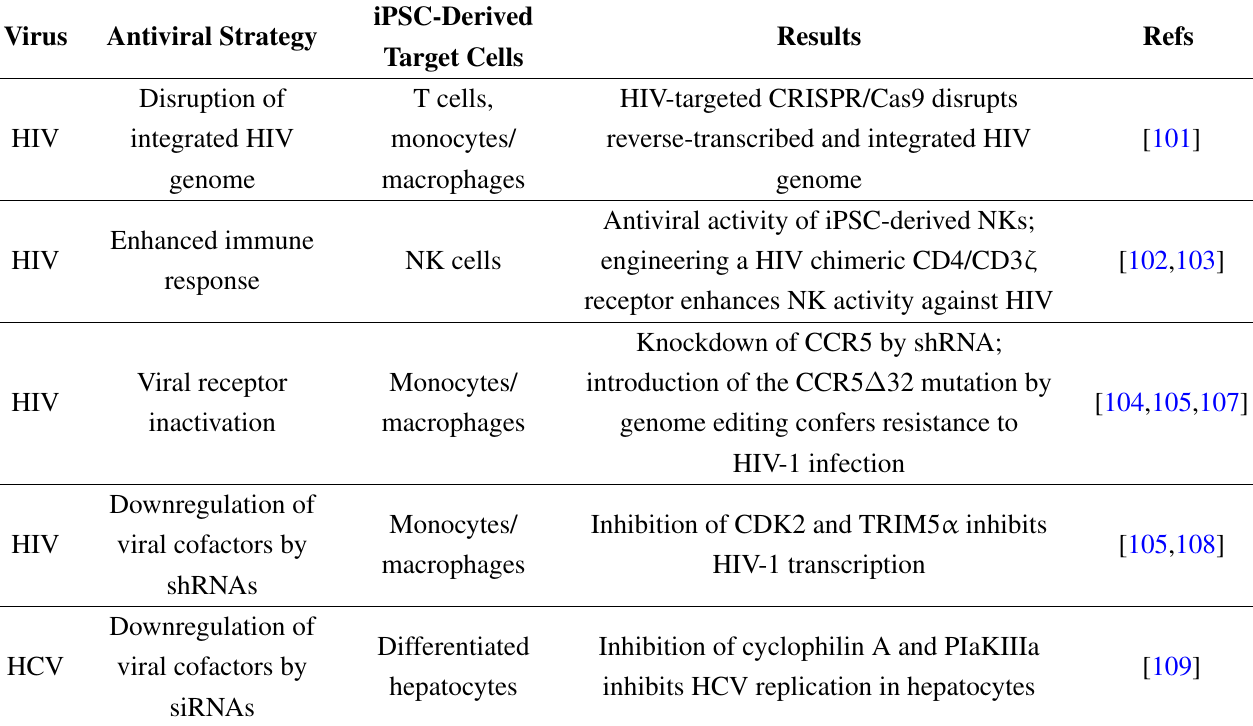
Table 3. Patients-specific induced pluripotent stem cell (iPSC)-based antiviral strategies.